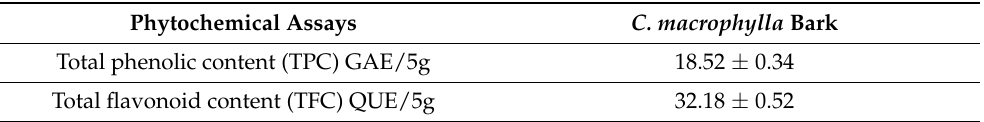
Table 4. Total phenolic content and total flavonoid content C. macrophylla Bark. Phytochemical